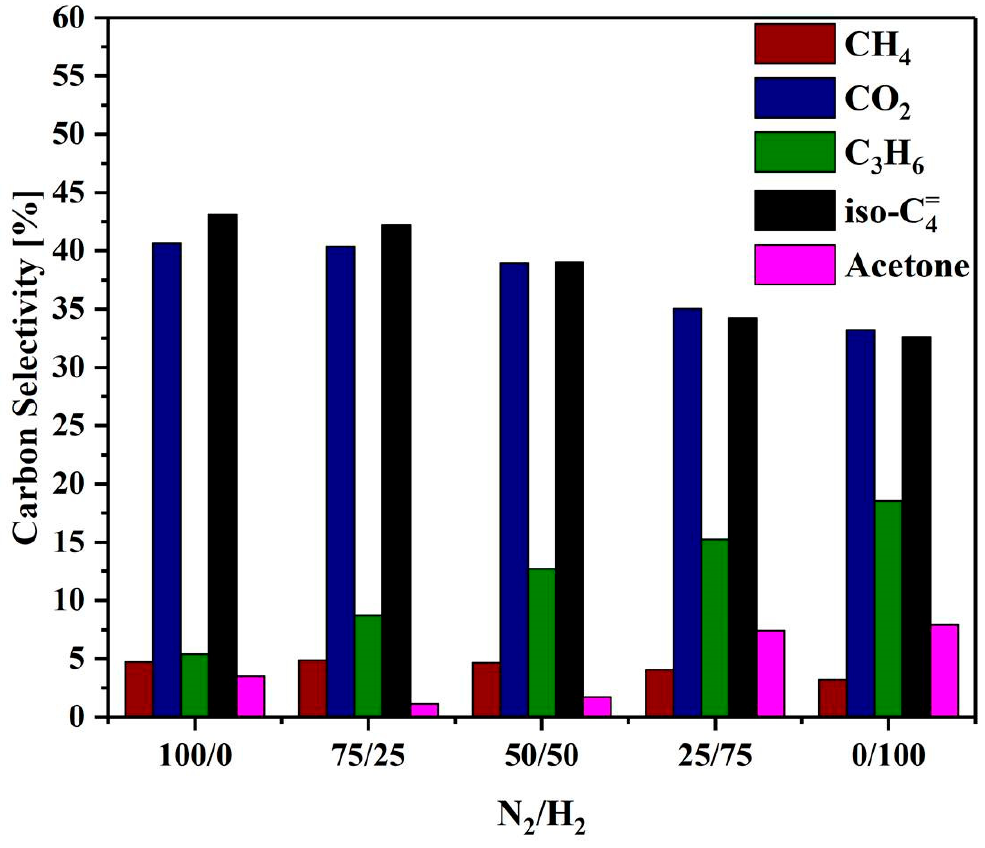
Figure 6. Effect of gas environment on product selectivity. Feedstock: 20 wt % ethanol in water, S/C = 5.1, Temperature: 450 °C, GHSV: 1200 h − 1 , catalyst loading 0.7 g, N 2 /H 2 composition was constant at 50 vol%.